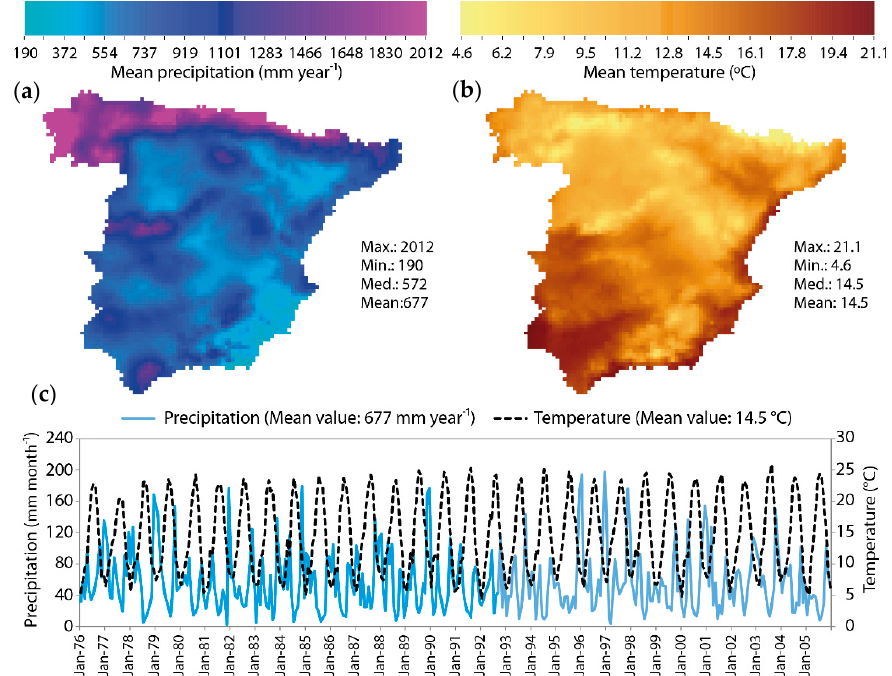
Figure 3. Map of historical mean ( a ) precipitation (mm year − 1 ) and ( b ) temperature (°C) across continental Spain during the reference period (1976–2005), ( c ) temporal series of mean precipitation (mm year − 1 ) Modified from [29].